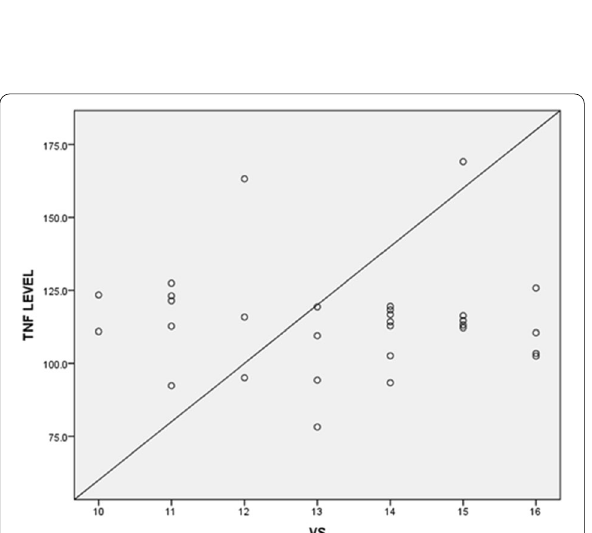
Fig. 2 Correlation between TNF‑α serum level and ACE visuospatial. TNF‑α serum level was significantly negatively correlated with